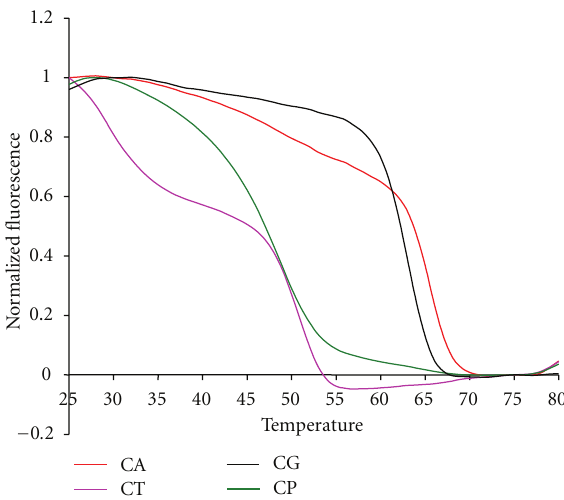
Figure 6: The anneal curve showing the fluorescent contour of the four tested Candida species in the Cal Red channel.